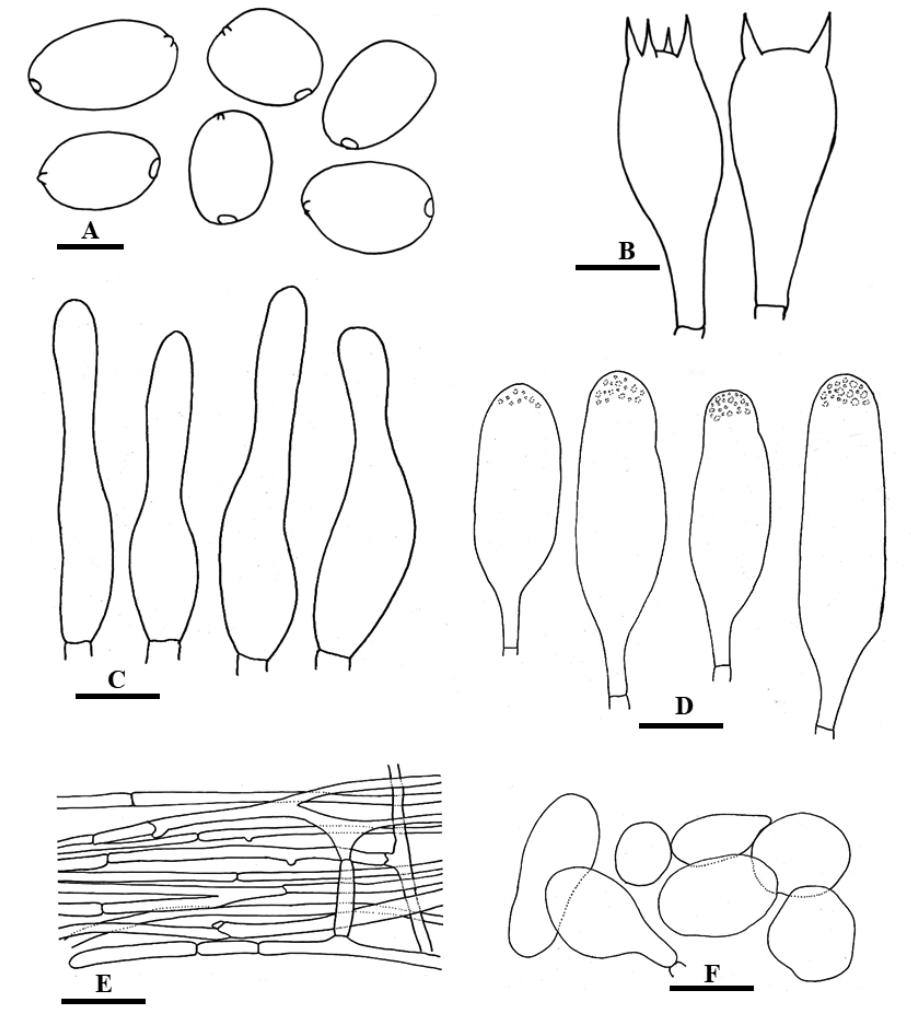
Figure 6. Line drawing of anatomical characters of Coprinellus pakistanicus A Basidiospores B Basidia C Pileocystidia D Cheilocystidia E Pileal hyphae F Veil elements. Scale bars: 10 µm ( A ), 20 µm ( B–F ). 1.3; in face view, broadly ellipsoid, obovoid to phaseoliform, in side view, ovoid, ellip- soid to obovoid, base not truncate, apiculus slightly visible, germ-pore central, smooth, slightly thin-walled, dark brown to blackish in KOH. Basidia 13.5–32 × 8.5–12 µm, clavate to narrowly clavate, hyaline, smooth, 2- to 4-spored, sterigmata up to 4 µm in length. Cheilocystidia 42–75 × 14–25 µm, cylindrical to lageniform, hyaline with crystals usually at the apex of cystidium. Pleurocystidia absent. Pileipellis irregular epithelium, 3.5–7.5 µm diam., pale to hyaline in KOH. Pileocystidia 30–90 ×